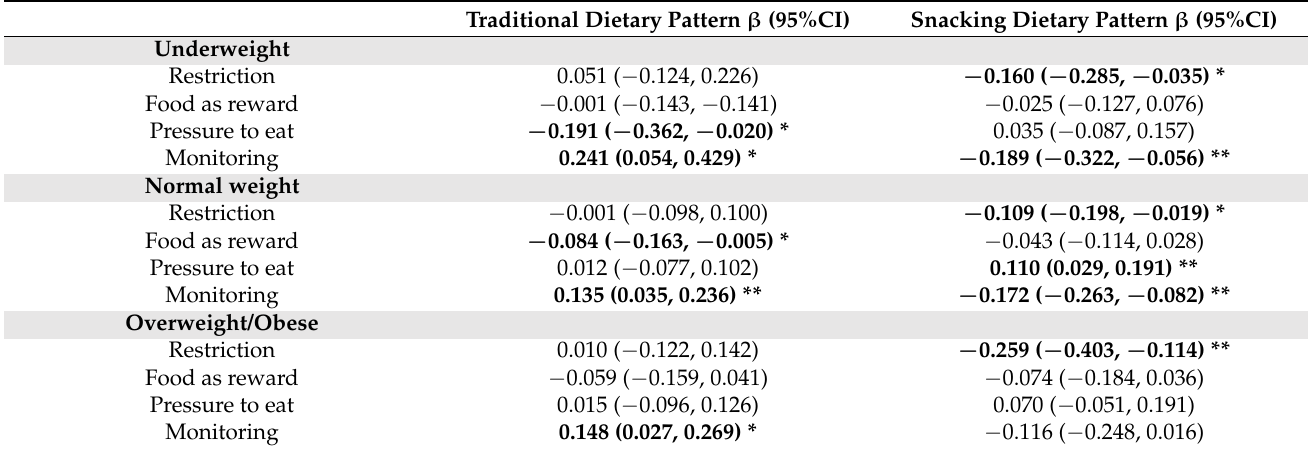
Table 5. Linear regression relationships between parental feeding practices and children’s dietary patterns among different ZBMI weight status of